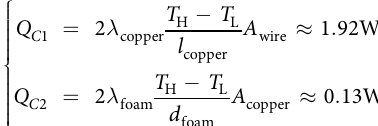
I PCS in Fig. 3b) < 10% of the coil current 37 . For this magnets system, I PCS is limited to < 5 A, thus the minimum